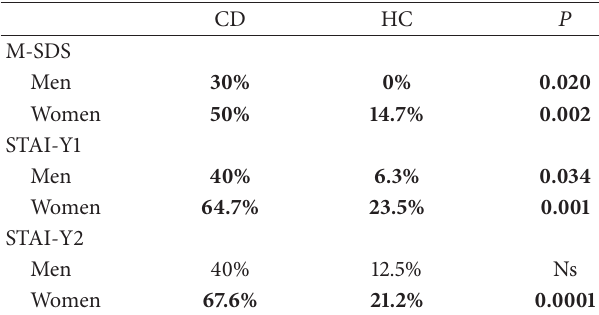
Table 3: The percentages of pathological M-SDS, STAI-Y1, and STAI-Y2 scale scores in celiac disease patients (CDP) and healthy controls (HC) according to gender. CD